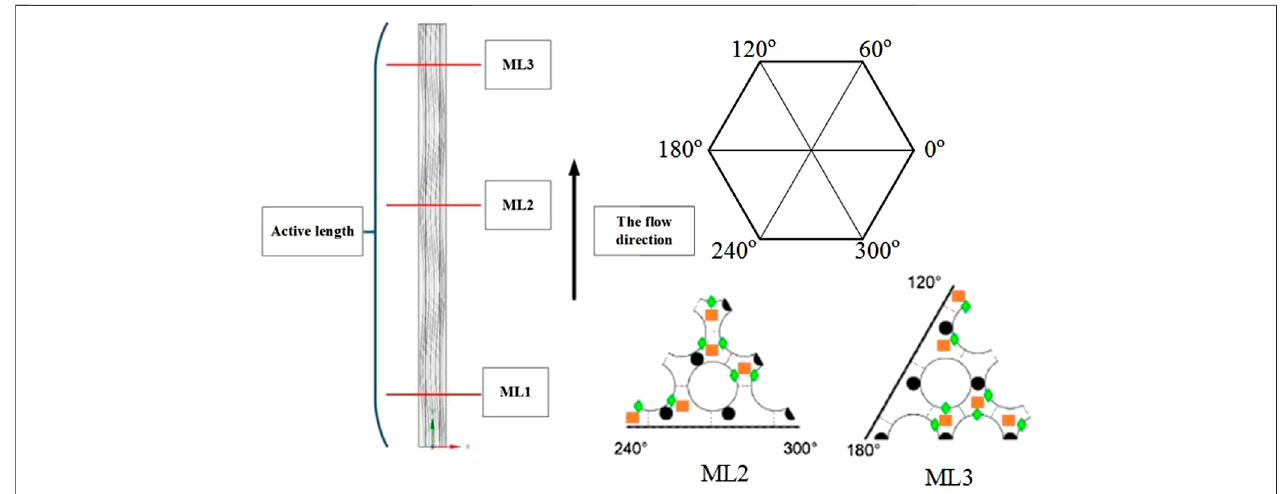
FIGURE4 | The schematic positions oftemperature measuringpoints in the sub-channels at ML2 and ML3 (Pacio et al., 2016) (Z: thedistancedownstreamof the entrance of the active length).